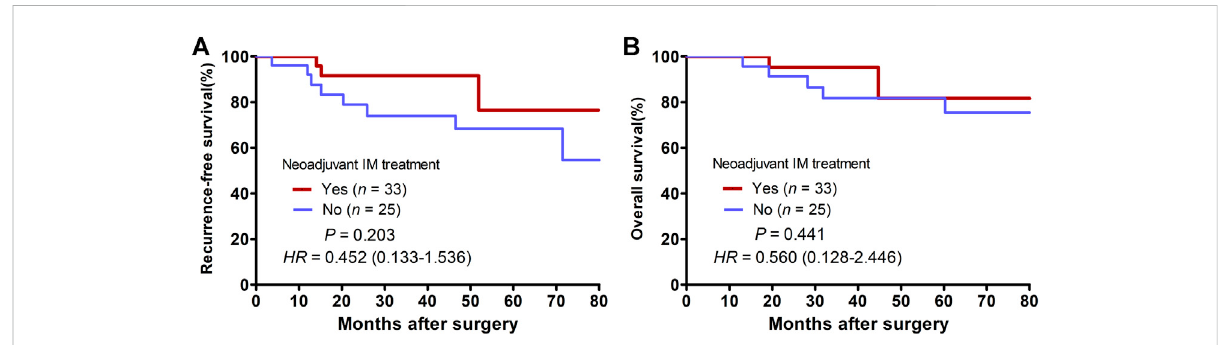
FIGURE 3 Kaplan-Meier curves of patients with locally advanced rectal GIST grouped by whether having received neoadjuvant Imatinib therapy. (A) Comparisonofrecurrence-freesurvivalbetweentheneoadjuvantgroupandthesurgeryalonegroup. (B) Comparisonofoverallsurvivalbetweenthe neoadjuvant group and the surgery alone